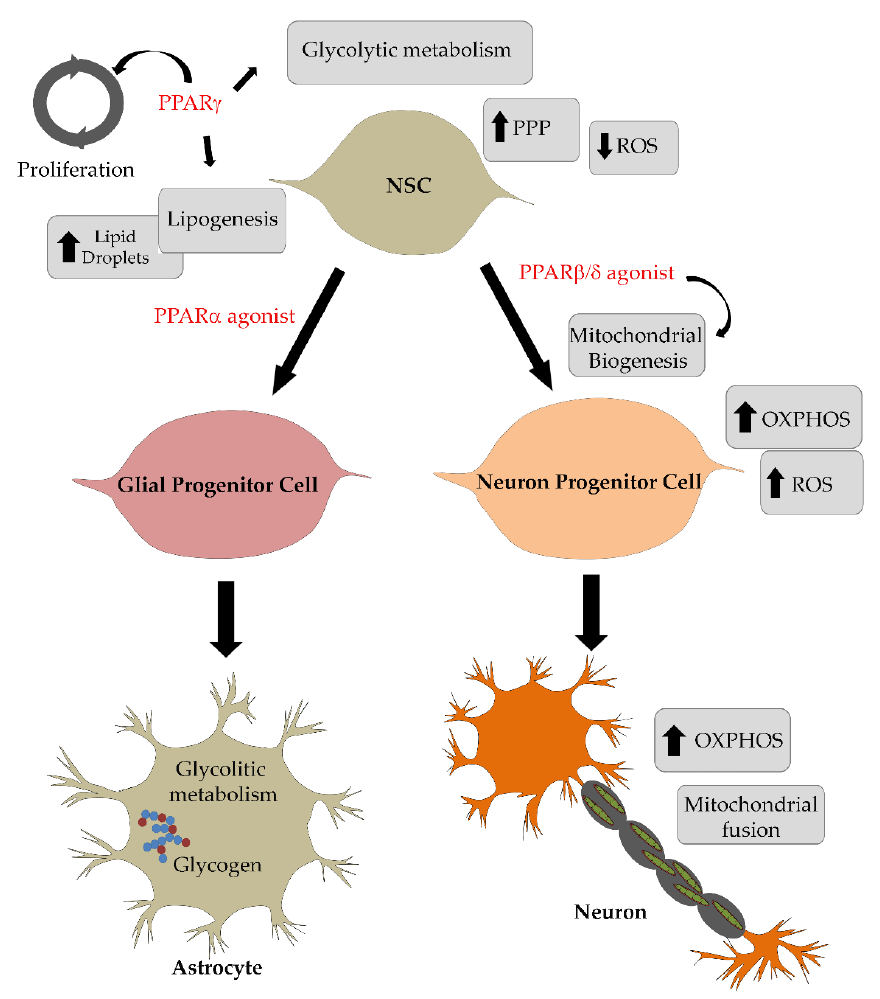
Figure 1. Scheme summarizing the effects of peroxisome proliferator activated receptors (PPARs) on energy metabolism adaptation during neural stem cells differentiation in neurons and astrocytes.